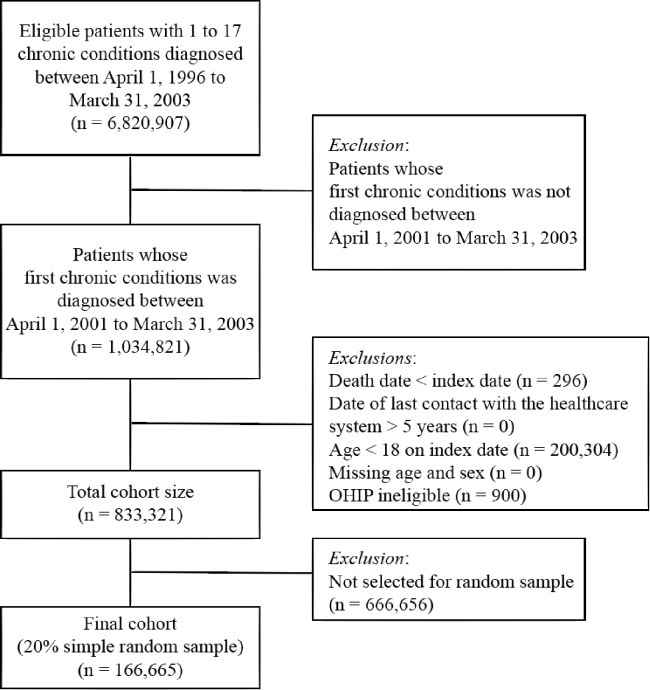
Selection of patients with a minimum of one out of seventeen chronic conditions for entry into the cohort (n = 166,665).